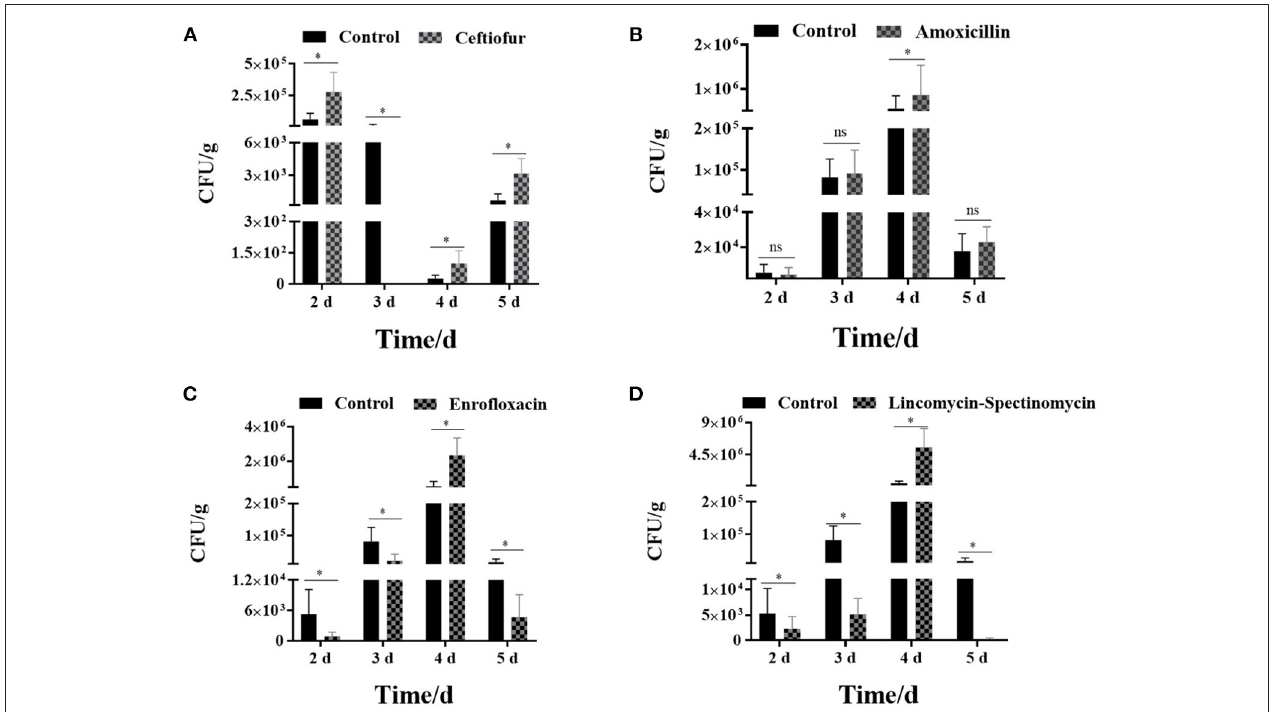
FIGURE 5 | Count of Salmonella vaccine strains in the cecum from various groups. (A) The number of Salmonella vaccine strains colonized in the cecum in the ceftiofur group. (B) The number of Salmonella vaccine strains colonized in the cecum in the amoxicillin group. (C) The number of Salmonella vaccine strains colonized in the cecum in the enrofloxacin group. (D) The number of Salmonella vaccine strains colonized in the cecum in the lincomycin-spectinomycin group. Differences between mean values were assessed by an unpaired two-tailed Student’s t -test (ns, non-significant; * P < 0.05 represents a significant difference in numbers between the two